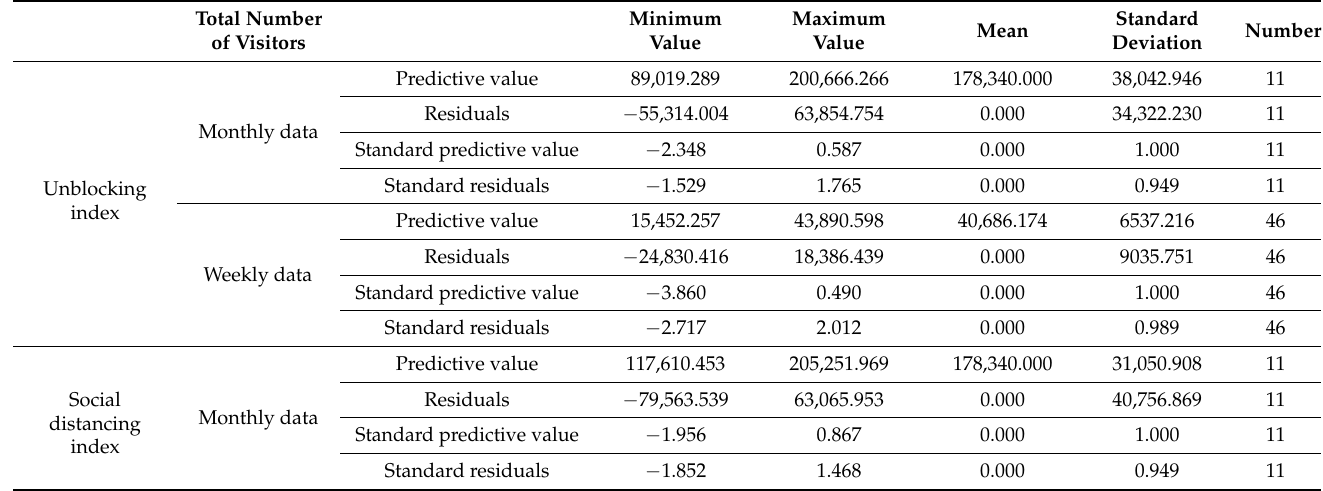
Table 3. Linear regression residuals